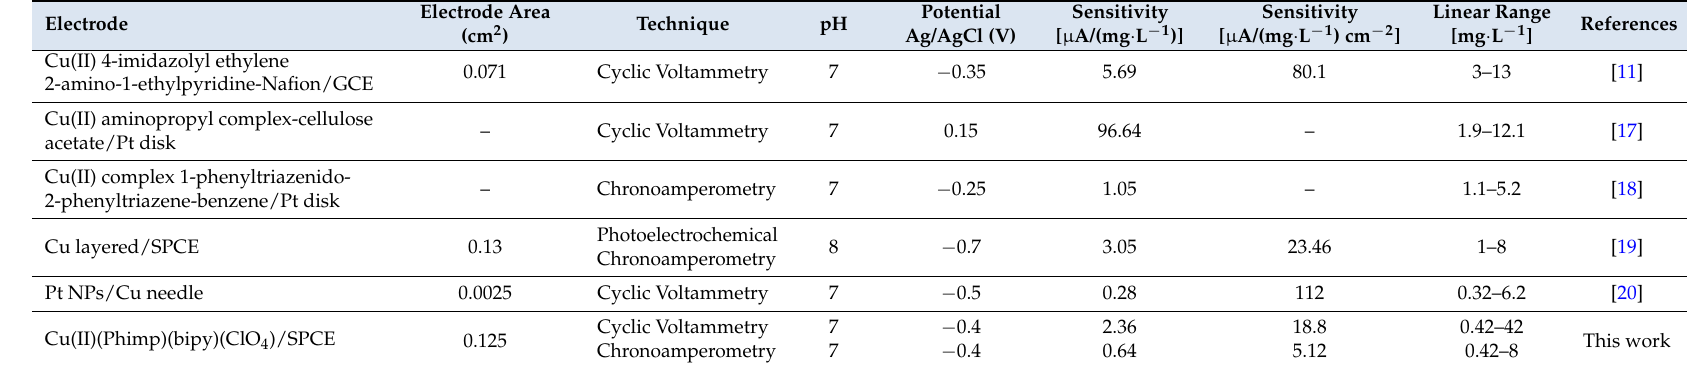
Table 1. Comparison of the sensing characteristics of previous Cu-based dissolved oxygen